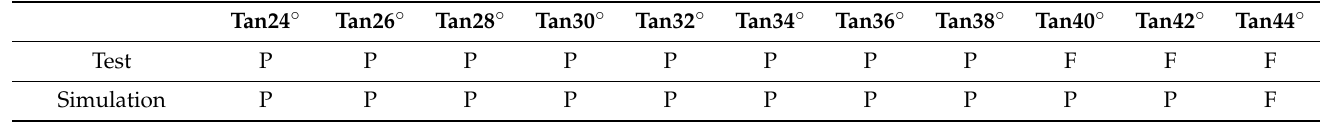
Figure 11. Comparison curves of pressure test and simulation. Table 3. The situation of real vehicle climbing over obstacles on different slopes (P for pass; F for failure).